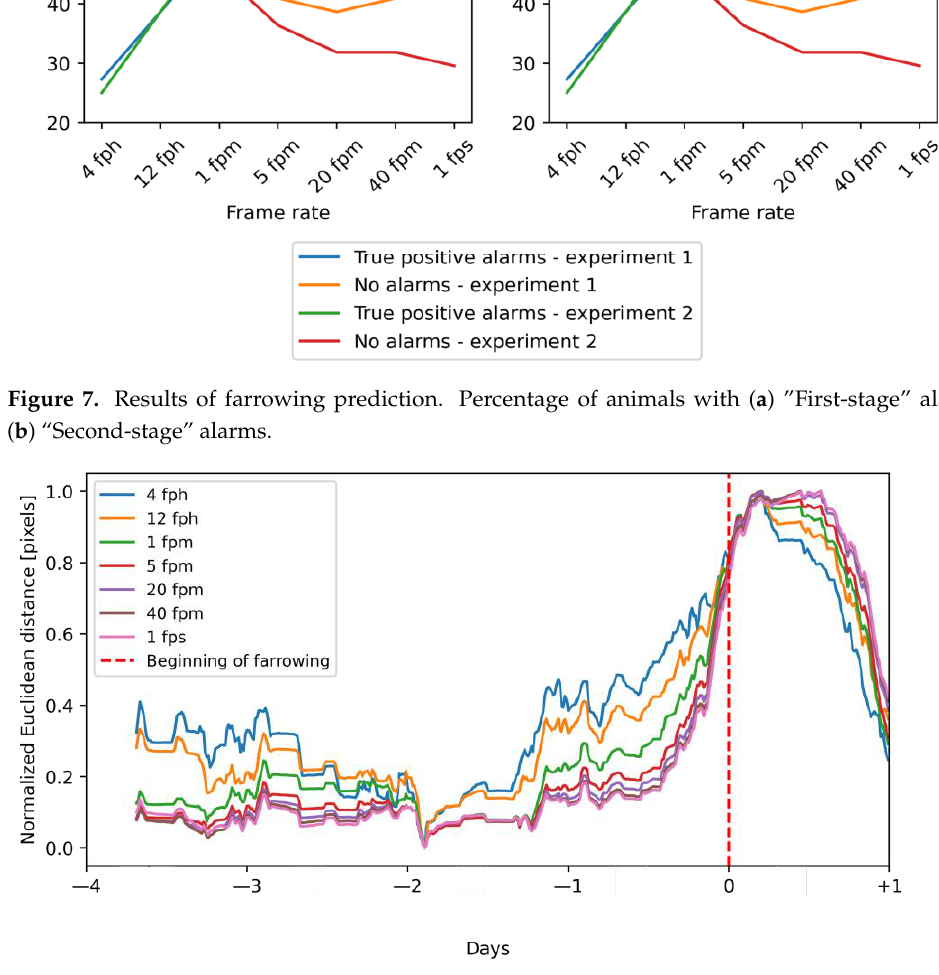
Figure 7. Results of farrowing prediction. Percentage of animals with ( a ) ”First - stage” alarms. ( b ) “ Second- stage” alarms.